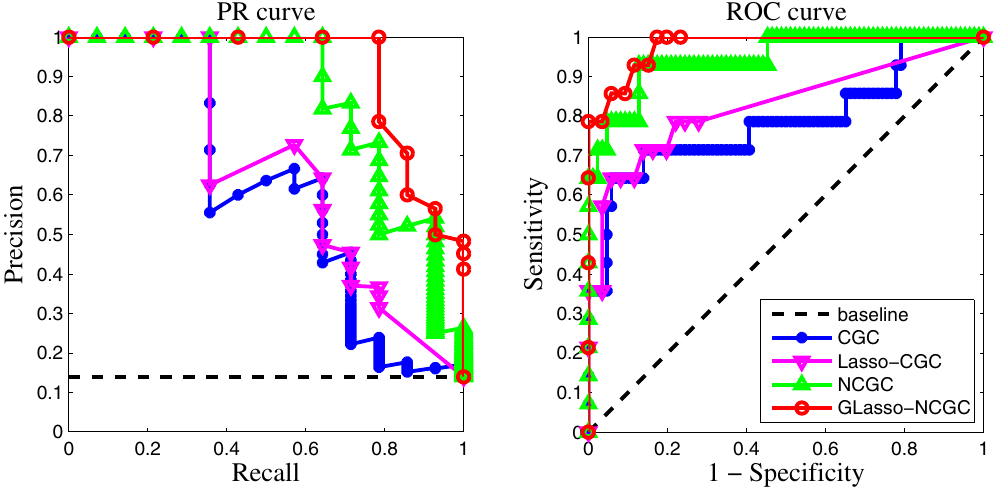
Figure 3. PR curves and ROC curves of CGC, Lasso-CGC, NCGC, GLasso-NCGC in nonlinear VAR